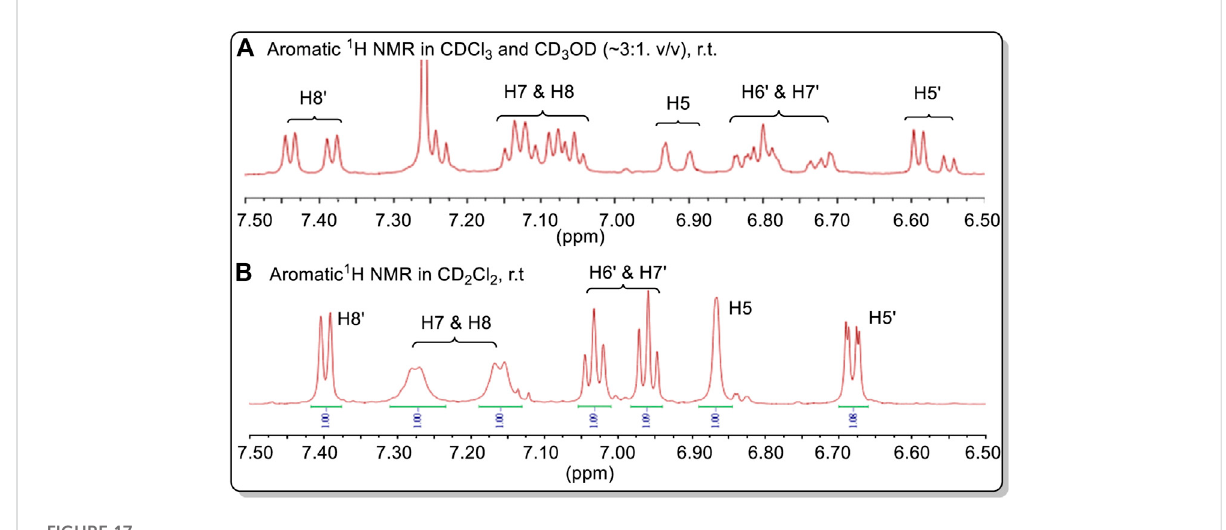
FIGURE 17 (A) Aromatic 1 H NMR spectra of 38 in CDCl 3 + CD 3 OD. (B) The aromatic 1 H NMR spectra of 38 in CD 2 Cl 2 . Compound 38 had a relatively low solubility in CDCl 3 . Minor amounts CD 3 OD can signi fi cantly increase its